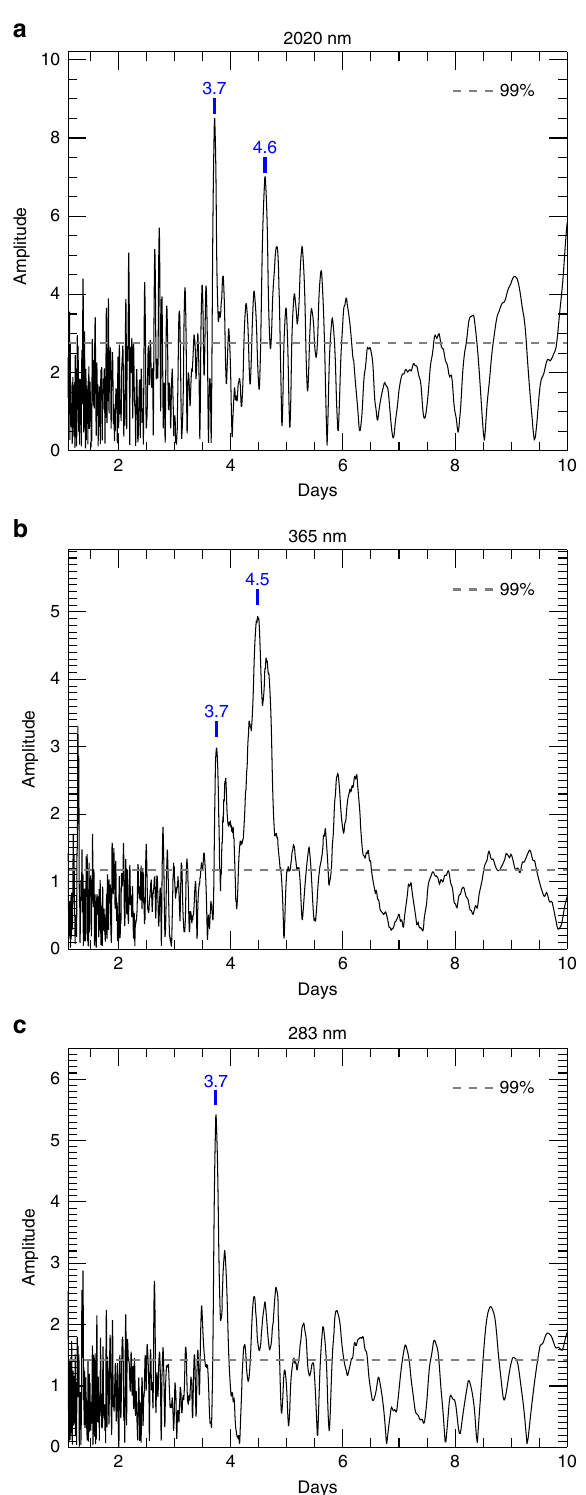
Fig. 3 Periodograms of the deviations (%) in the disk-integrated brightness with respect to the mean phase curve in 2016. ( a ) is at 2020 nm; ( b ) is at 365 nm; ( c ) is at 283 nm. The numbers in blue indicate the periods in Earth Days. 99% signi fi cance levels are also